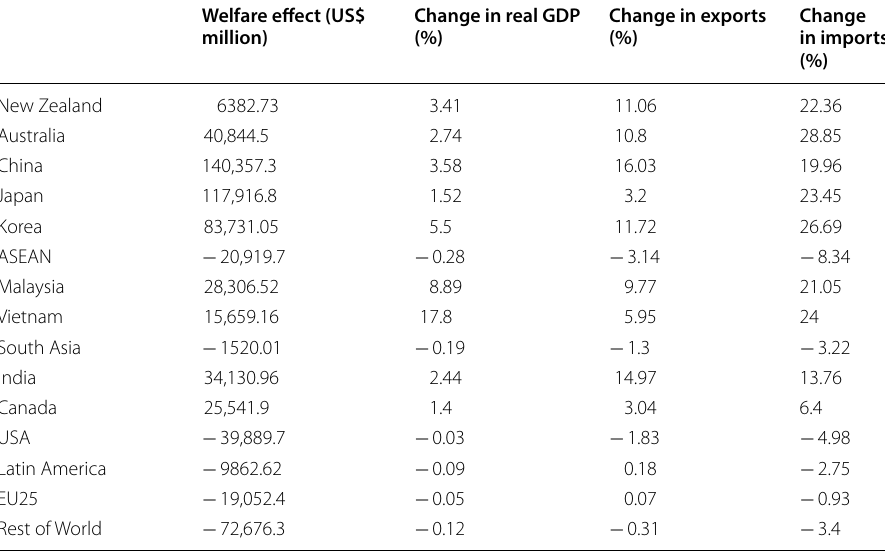
Table 9 Macroeconomic impact of tariff elimination and 25% increase in trade facilitation under Indo-Pacific 3. Source: Authors’ simulation from GTAP version